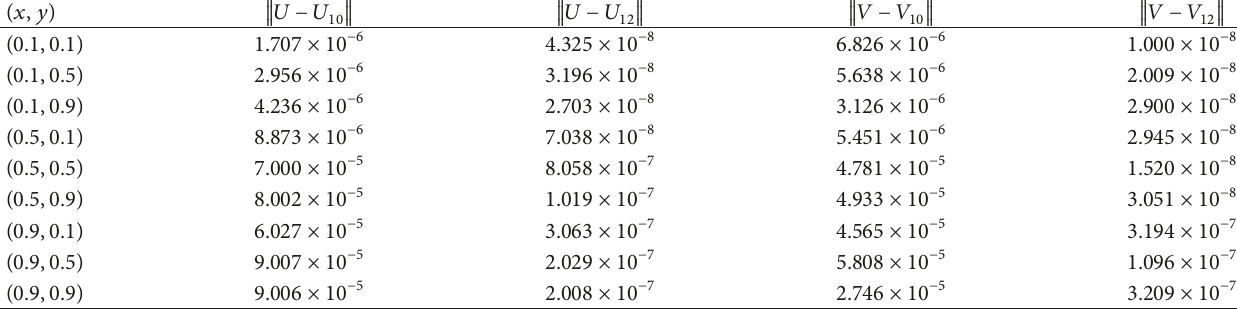
Table 5: Maximum absolute error in 𝑈(𝑥, 𝑦) and 𝑉(𝑥,𝑦) of Problem 3 at 𝐾 = 10, 12 corresponding to various values of (𝑥,𝑦)